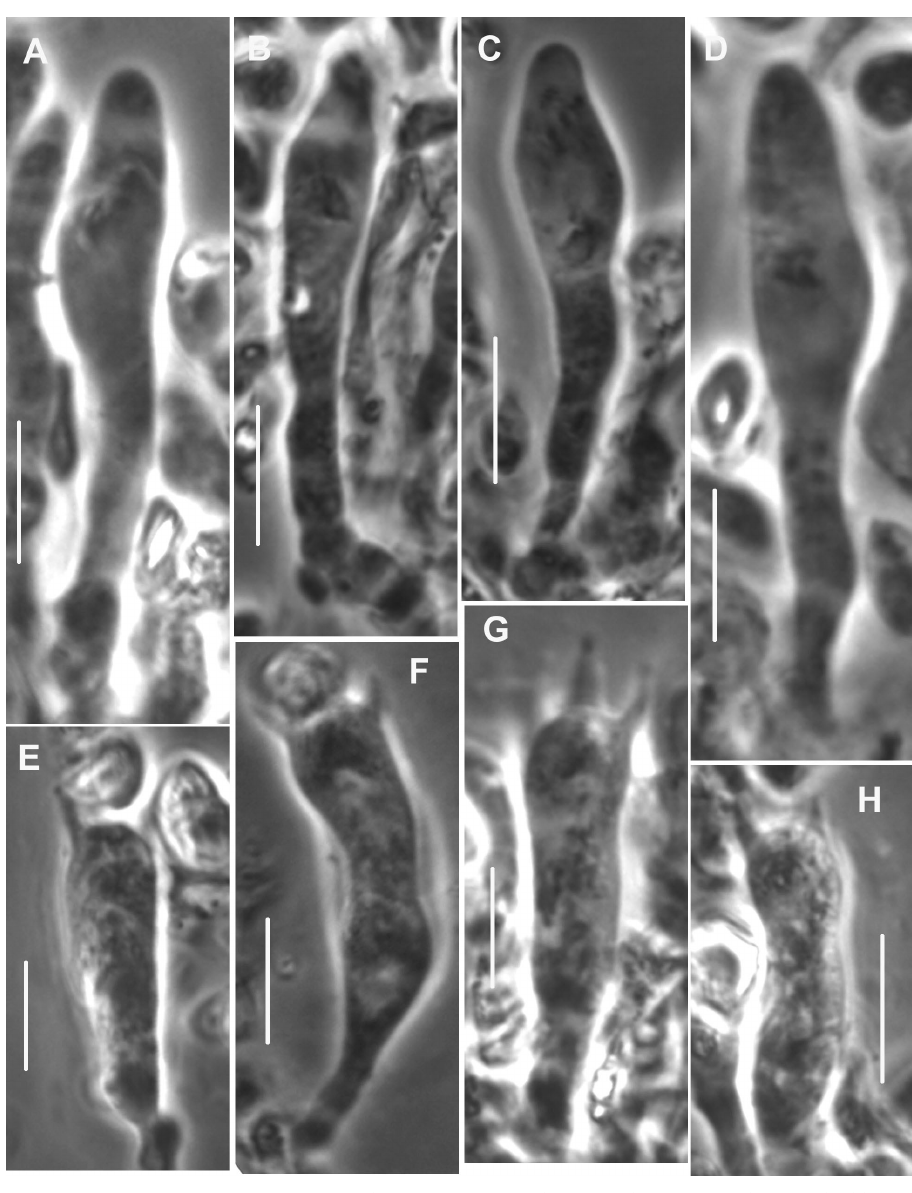
Figure 30. Mycetinis curraniae . Hymenial structures. A–D Pleurocystidia E–H Basidia. Standard bars = 10 µm. ZT 949